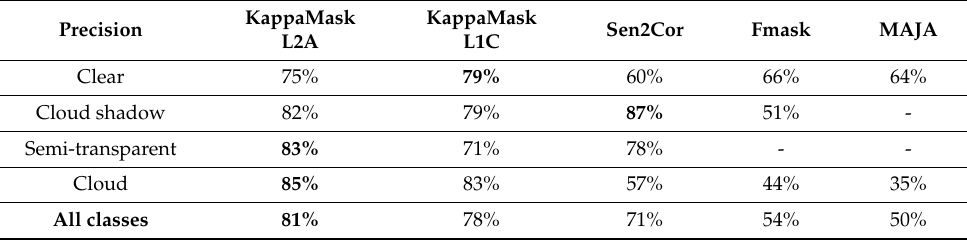
Table 3. Precision evaluation performed on the test dataset for KappaMask Level-2A, KappaMask Level-1C, Sen2Cor, Fmask and MAJA cloud classification maps. Evaluation is performed for clear, cloud shadow, semi-transparent and cloud